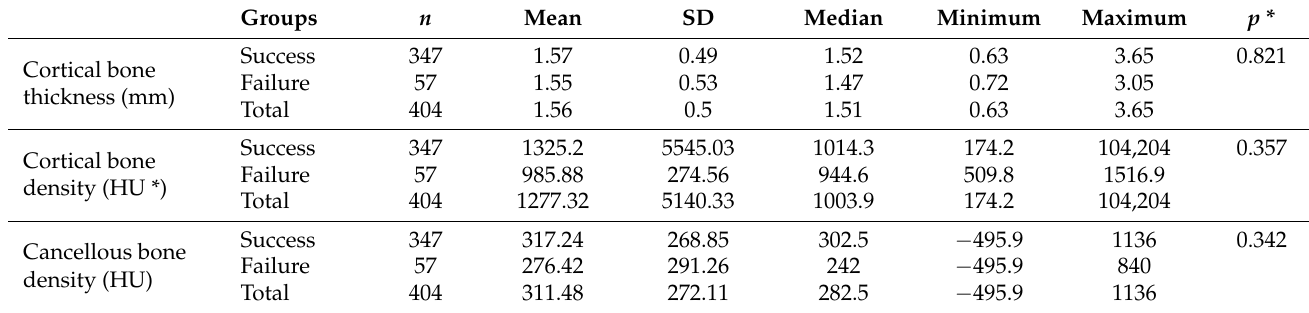
Table 3. Generalized estimating equation model used to assess the effect of bone density on the success of